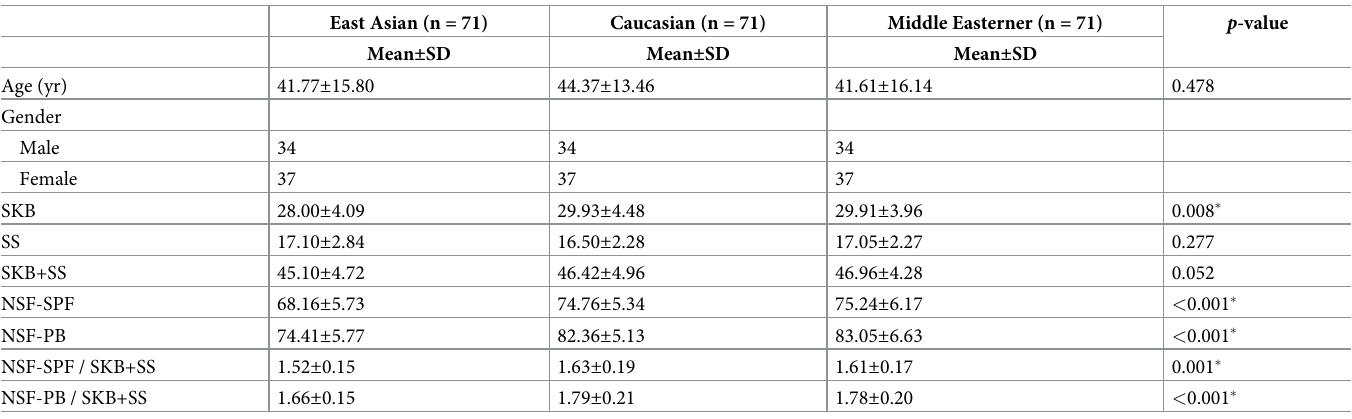
Table 2. Summary of patient characteristics and CT measurements by